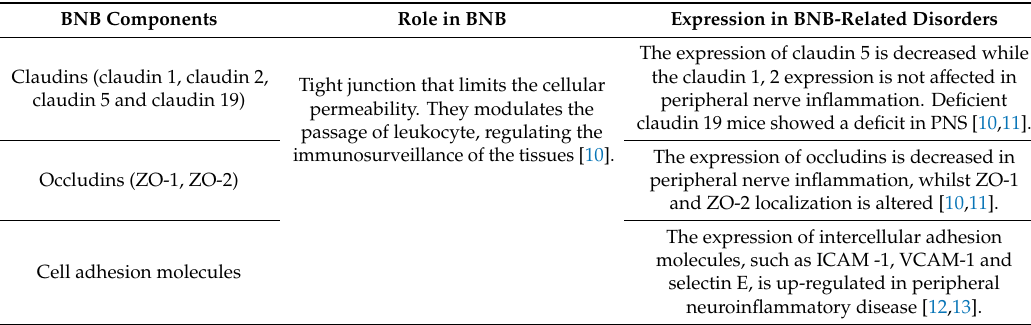
Table 1. Components of Blood Nerve Barrier (BNB) intracellular junctions.